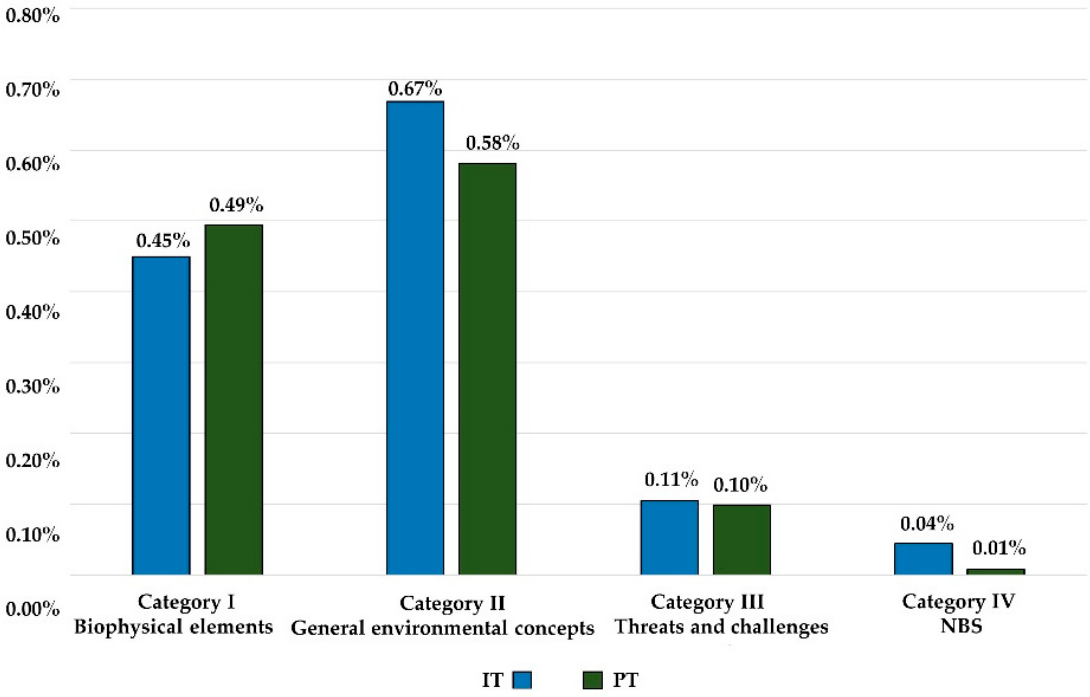
Figure 1. Frequency (%) of each category in the text of both resilience and recovery plans presented as the percentage of terms by the total amount of words in each document .